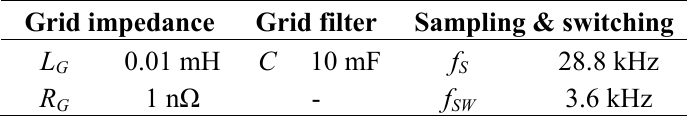
Table 3. Simulation parameters of the CSC-based system.